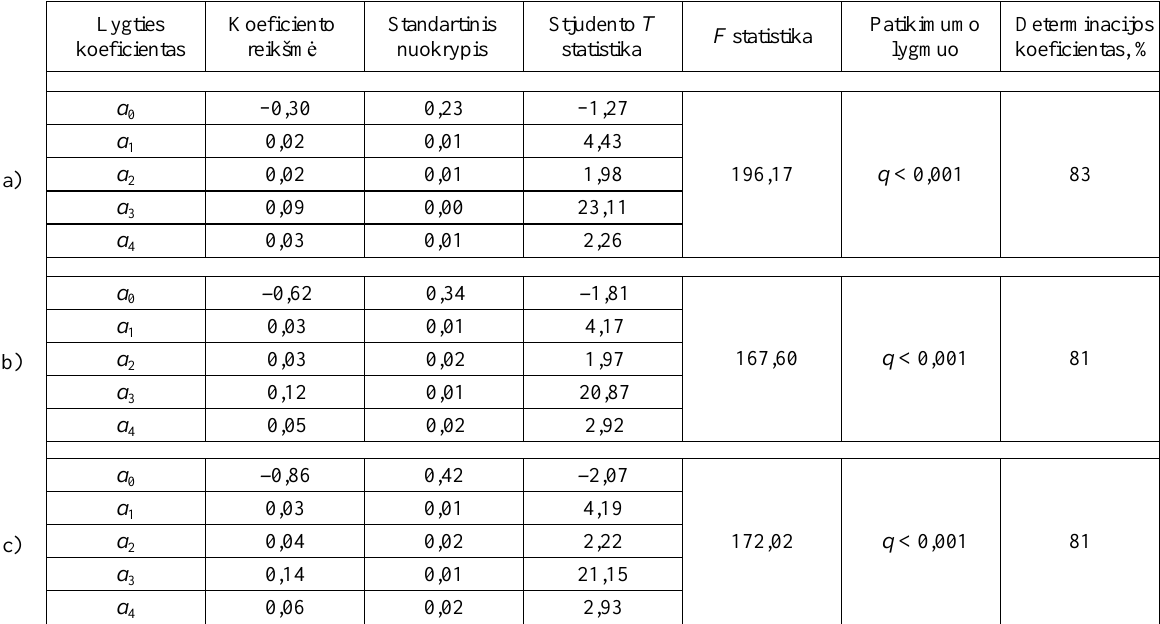
Table 3. Disperse analysis of regression